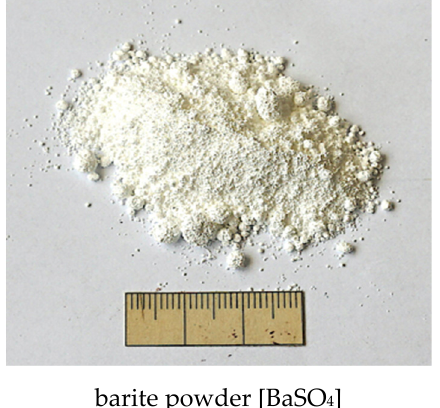
Figure 8. Tracers with different grain sizes.